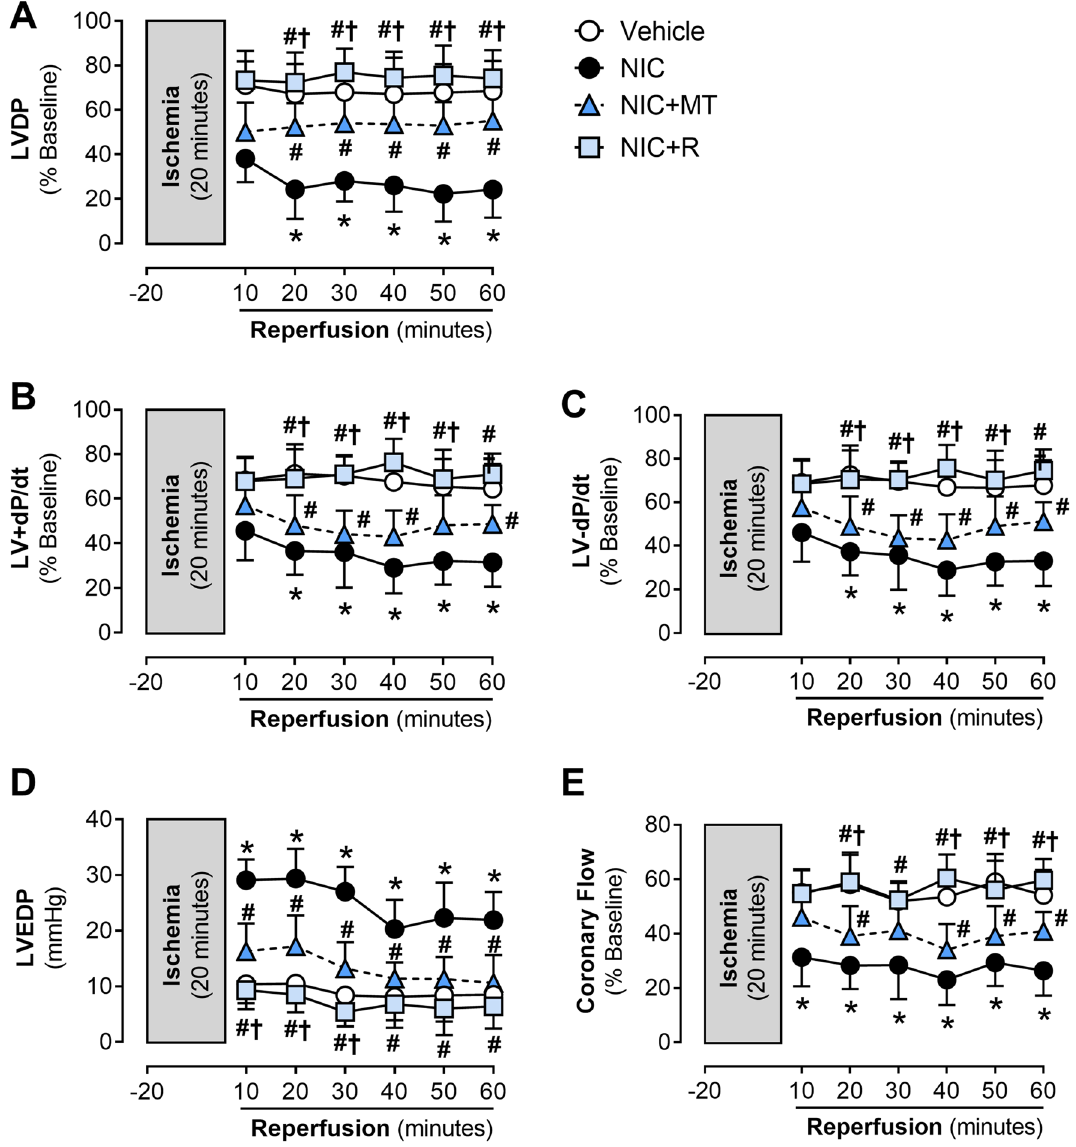
Figure 5. Time course changes in post-ischemic recovery of ( A ) LVDP, ( B ) LV + dP/dt, ( C ) LV − dP/dt, ( D ) LVEDP, and ( E ) coronary flow in Langendorff-perfused rat hearts isolated from the vehicle, NIC, NIC + MT, and NIC + R. All values are given as mean ± SEM for n = 6–8/group; * p < 0.05 versus vehicle group; # p < 0.05 versus NIC group and † p < 0.05 versus NIC + MT group using two-way ANOVA with repeated